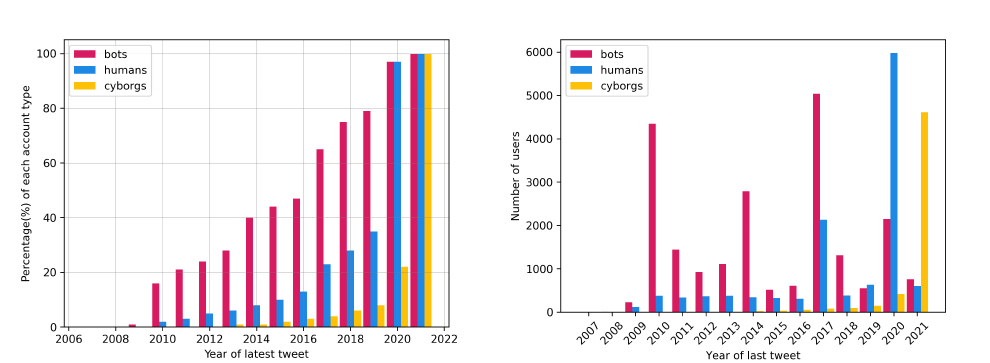
Figure 2. The figure on the left shows the percentage of accounts that stopped posting content per year. Interestingly more than 75% of bots remained inactive after 2017. The figure on the right shows the number of each type of account to the year they posted their last tweet. We observe that most labeled bot accounts that are included in the public datasets are no longer active.